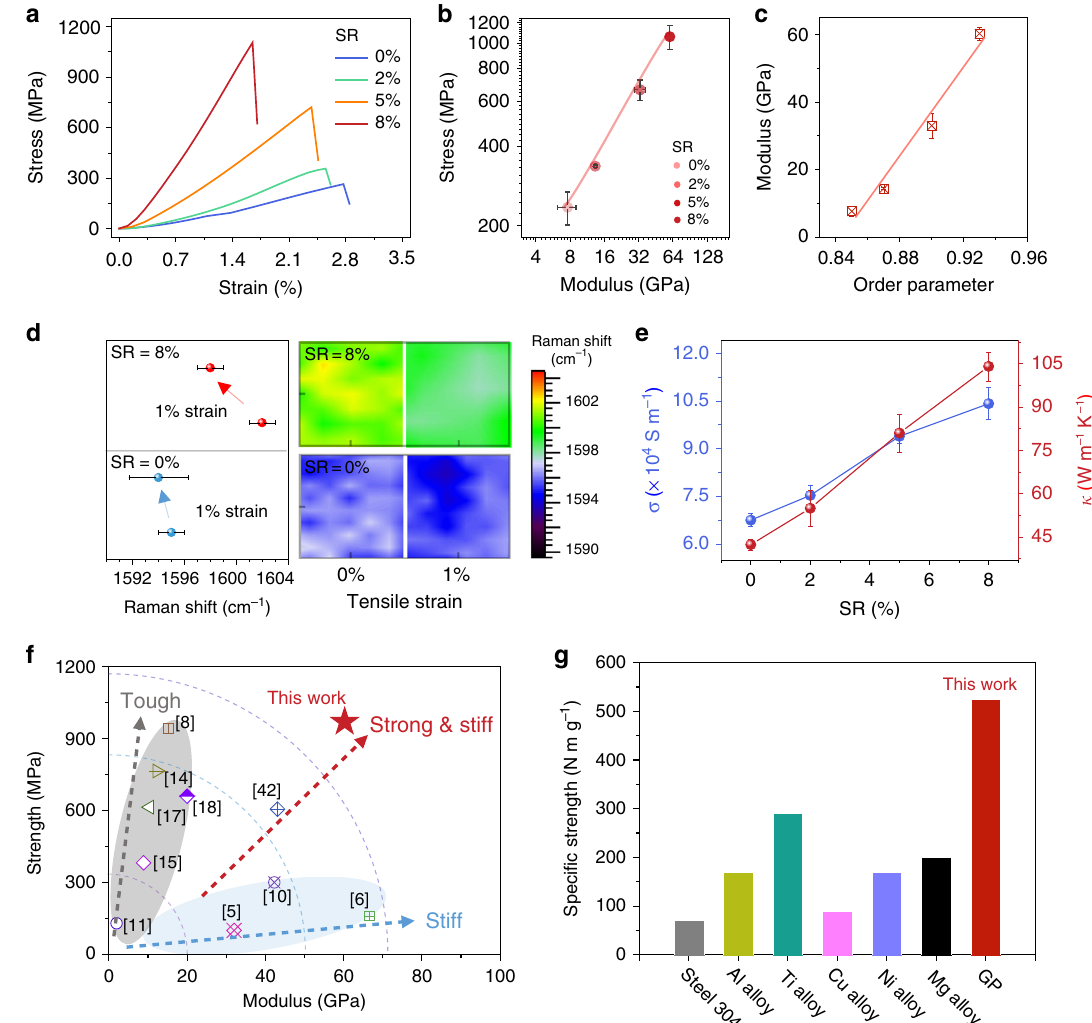
Fig. 6 Mechanical, electrical and thermal properties of graphene papers. a , b Mechanical strength and modulus of GPs at different SR . c Relationship between Young ’ s modulus and the order parameter, f . d Raman shifts of G-band of direct-cast (blue points) and 8%-GPs (red points) at 1% strain. All Raman images collected within an area of 10 × 10 μ m 2 . e Electrical ( σ ; blue points) and thermal ( κ ; red points) conductivities of GPs at different SR . f Comparison of strength and modulus of 8%-GPs with previous reported GPs. Data represent means + s.d. g Comparison of speci fi c strength of 8%-GPs with conventional metal